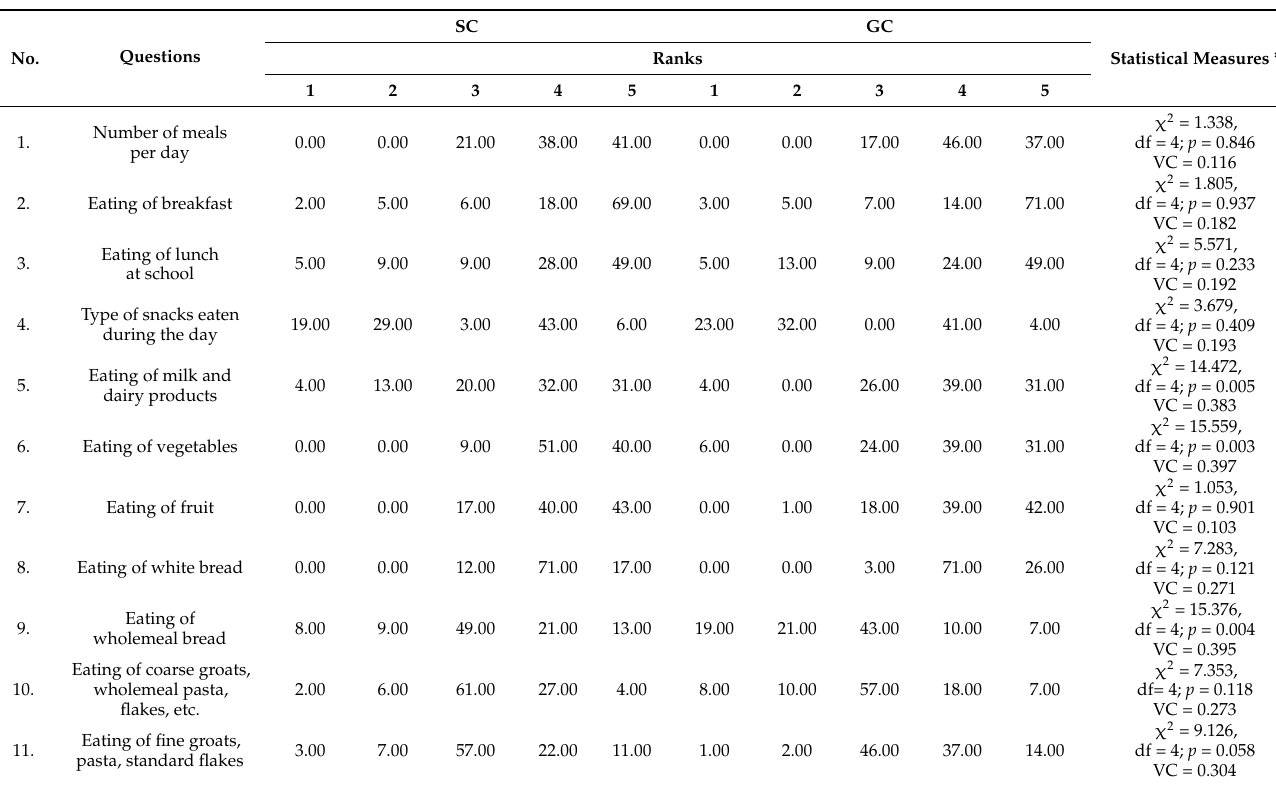
Table 2. Eating behaviour of children in the initial assessment session (2017), % of particular ranks in the